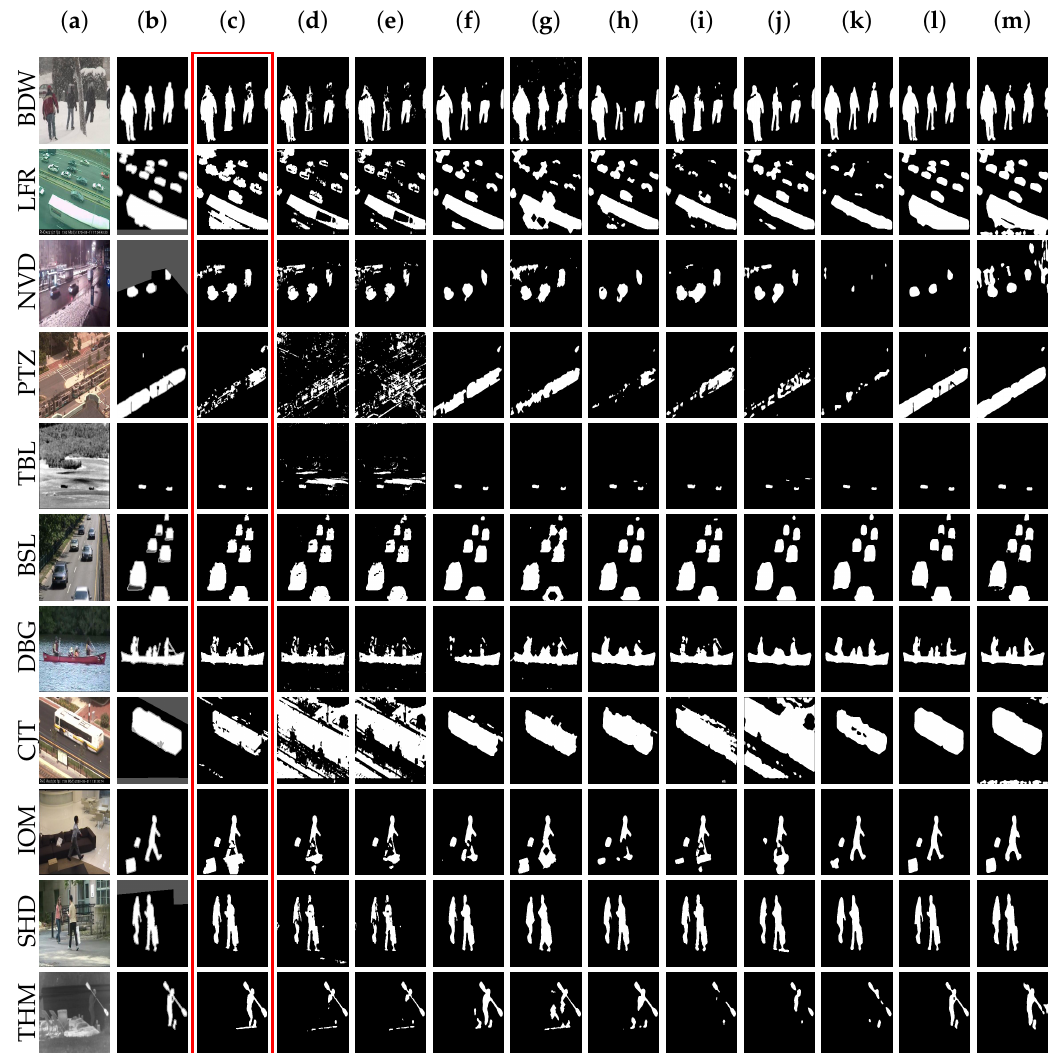
Figure 4. Visual quality comparison for foreground detection on some of video sequences in eleven categories from CDnet 2014. The columns include ( a ) input frame, ( b ) corresponding groundtruth foreground, ( c ) TensorMoG, ( d ) GMM—Stauffer & Grimson, ( e ) GMM—Zivkovic, ( f )